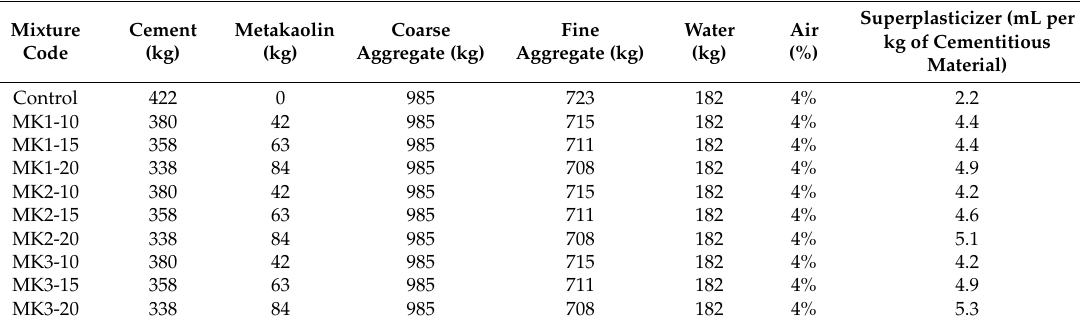
Table 3. Concrete batch quantities (per m 3